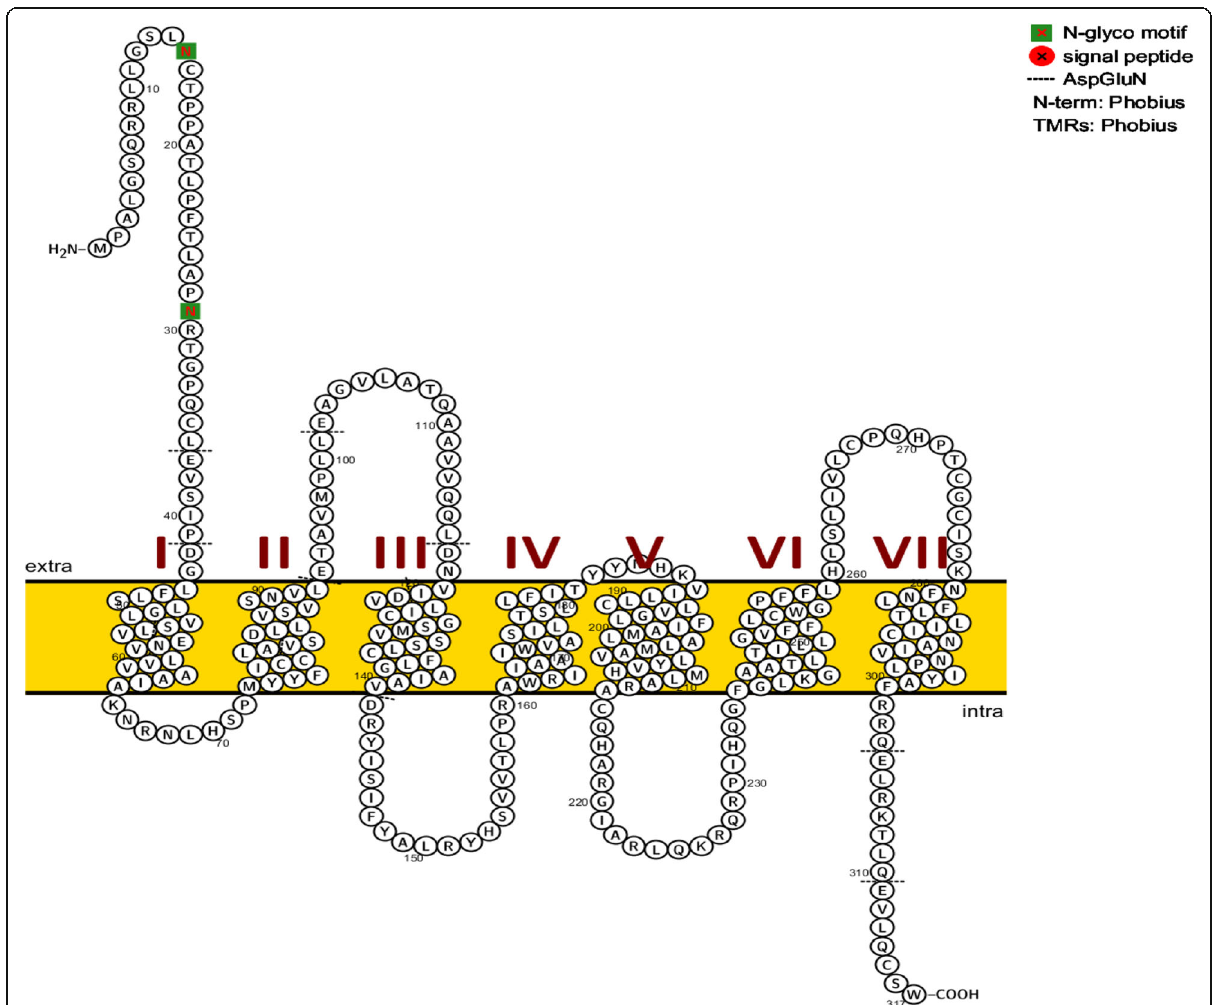
color of 136 swamp buffaloes, 31 hybrid off-springs